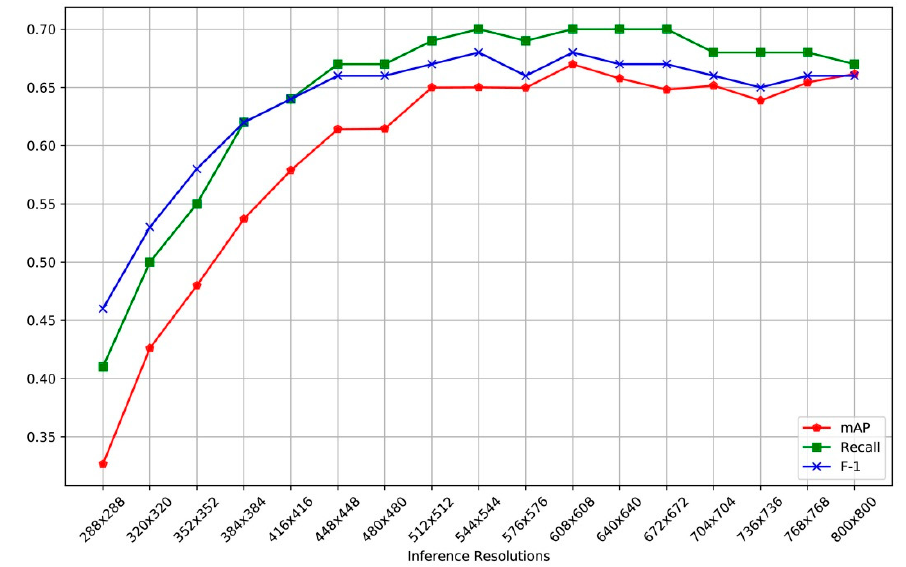
Figure 4. Metrics results for different input resolutions.